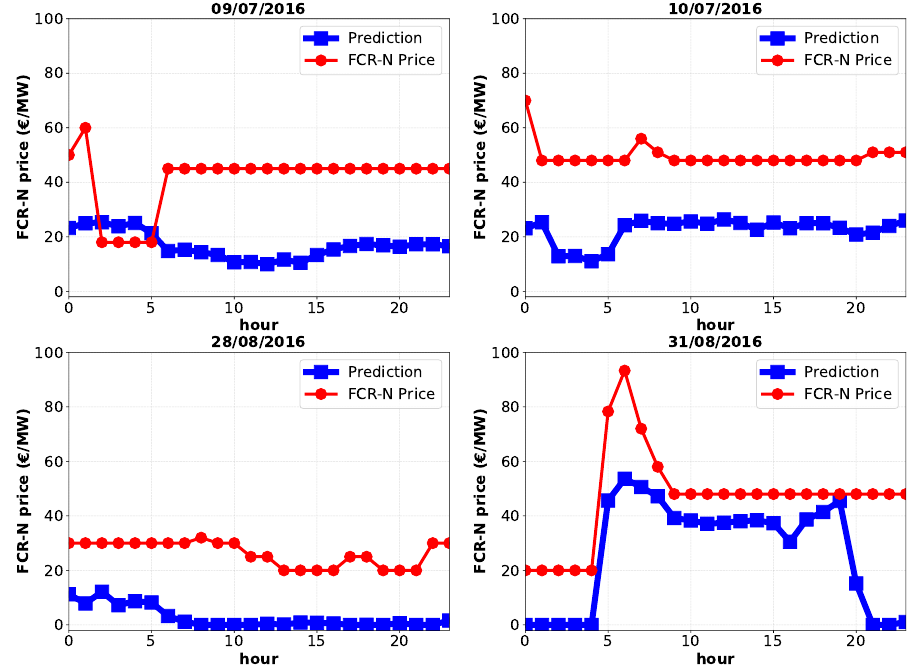
Figure 19. Examples of four outlier days in terms of FCR-N price behaviors in the period July–August 2016. Part of the methodology involves the decision on how often the computationally-intensive retraining of the ANN needs to be performed. Thus, the second experiment aimed at analyzing how the performance of the ANN model degraded when the ANN model was utilized for predicting several days in the future without a retraining of the model. Figure 21 presents the prediction performance (in terms of MSE) of the ANN model up to seven days in the future for the year 2016, where the median of the daily performance is represented with a line, while the daily mean performance is represented as a triangle. The prediction performance degraded linearly with respect to the number of days in the future to be predicted, going from an MSE of 115.8 for the first day to 139.6 for the seventh day after training the ANN model. At the same time, the distance between the median and the mean, as well as the variance of the prediction performance increased, indicating that a short retraining period of the ANN model was desirable to reduce the prediction errors on outlier price